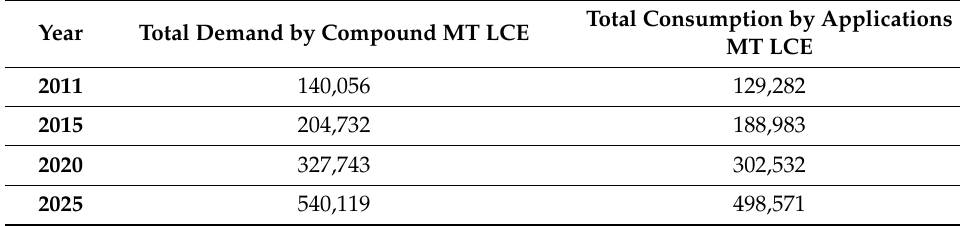
Table 1. Demand and consumption of lithium salts-Forecast 2011–2025